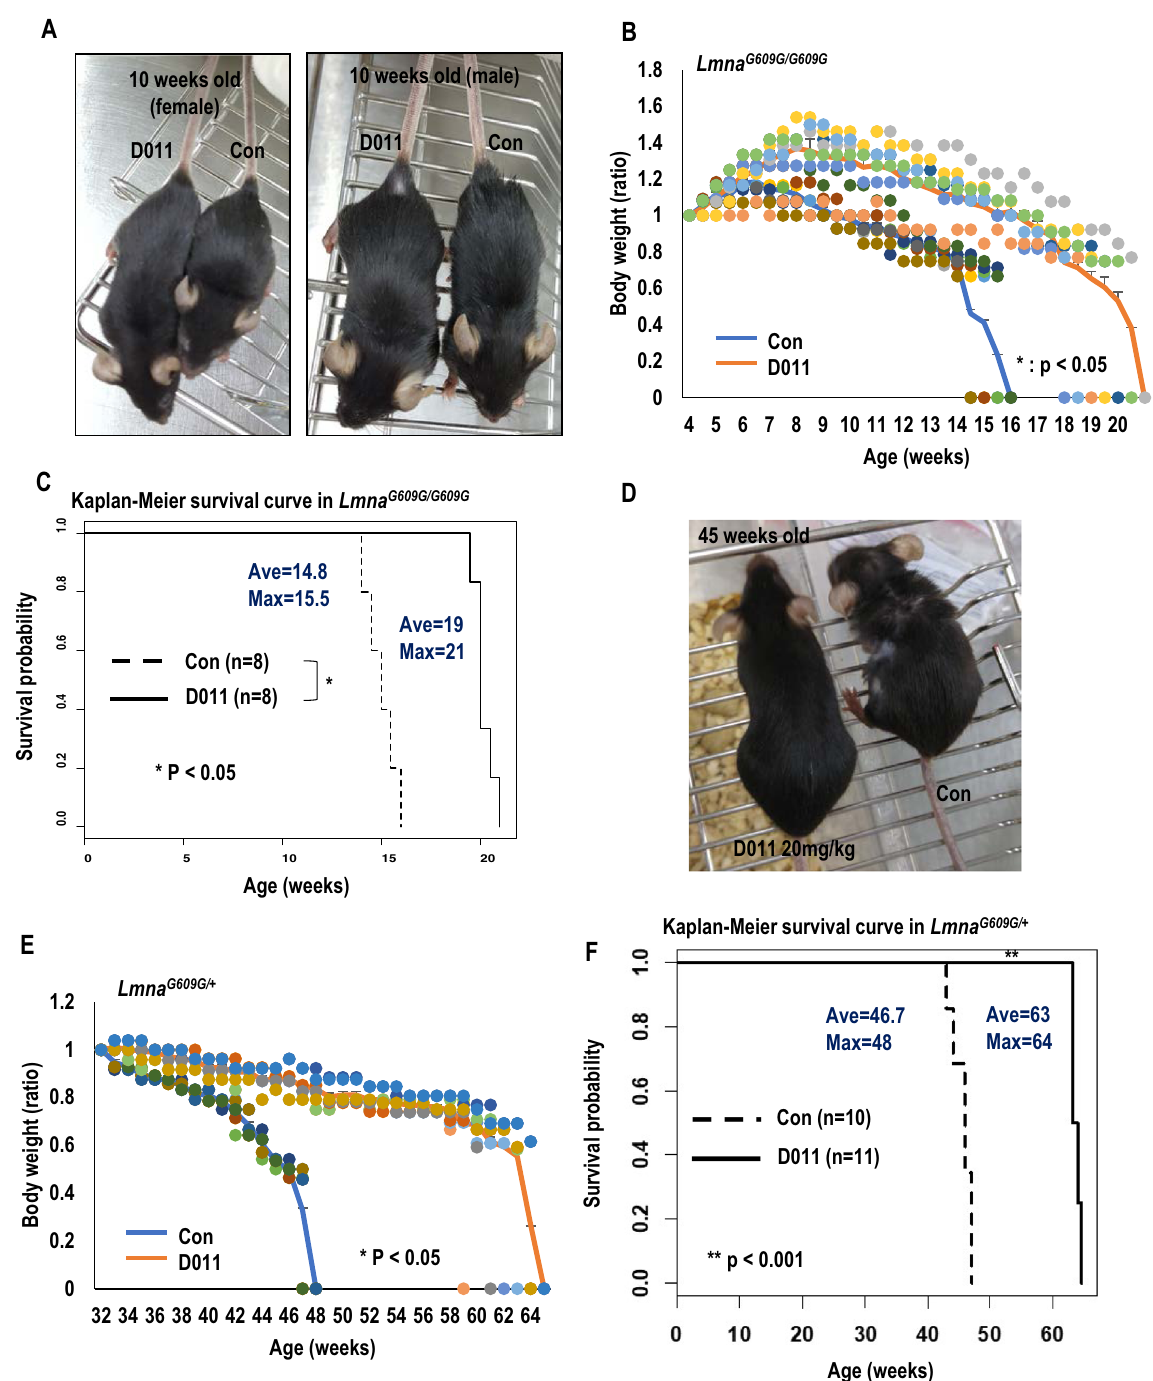
Fig. 3 In vivo favorable effect of SLC-D011. A Gross morphology of Lmna G609G/G609G mice (10 weeks old) was ameliorated after injection with SLC-D011. At the same age, the experimental group (D011) of mice were larger than vehicle-injected control (Con) subjects regardless of gender. B , C SLC-D011 increases body weight B and extends life span C of Lmna G609G/G609G progeria model mouse (Con: n = 8; SLC-D011: n = 8). Compared with 14.8 weeks of average (ave) life span with maximum (max) life span of 15.5 weeks, 20 mg/kg of intraperitoneal (i.p) injection (twice a week) of SLC-D011 could extend the life span upto 19 weeks (max = 21 weeks). Lmna G609G/G609G mice were injected with SLC-D011 from age of 5-week old, * p < 0.05. D Gross morphology of SLC-D011 injected Lmna G609G/ + mouse. Sickly and weak features were observed in 45 weeks old Lmna G609G/ + mouse, but not observed in treated mouse, although they had the same age. E SLC-D011 increases body weights of Lmna G609G/ + mice (Con: n = 10; SLC-D011: n = 11), * p < 0.05. F Favorable effect of SLC-D011 on life span of Lmna G609G/ + mice. Compared with vehicle-injected control group (ave = 46.7 weeks and max = 48 weeks), SLC-D011 treatment obviously extended the average life span to 63 weeks (max = 64 weeks). The injection was started from 32 weeks old, ** p < 0.001. “ Con ” means vehicle (a solvent composed of DMSO and PBS)-injected mouse